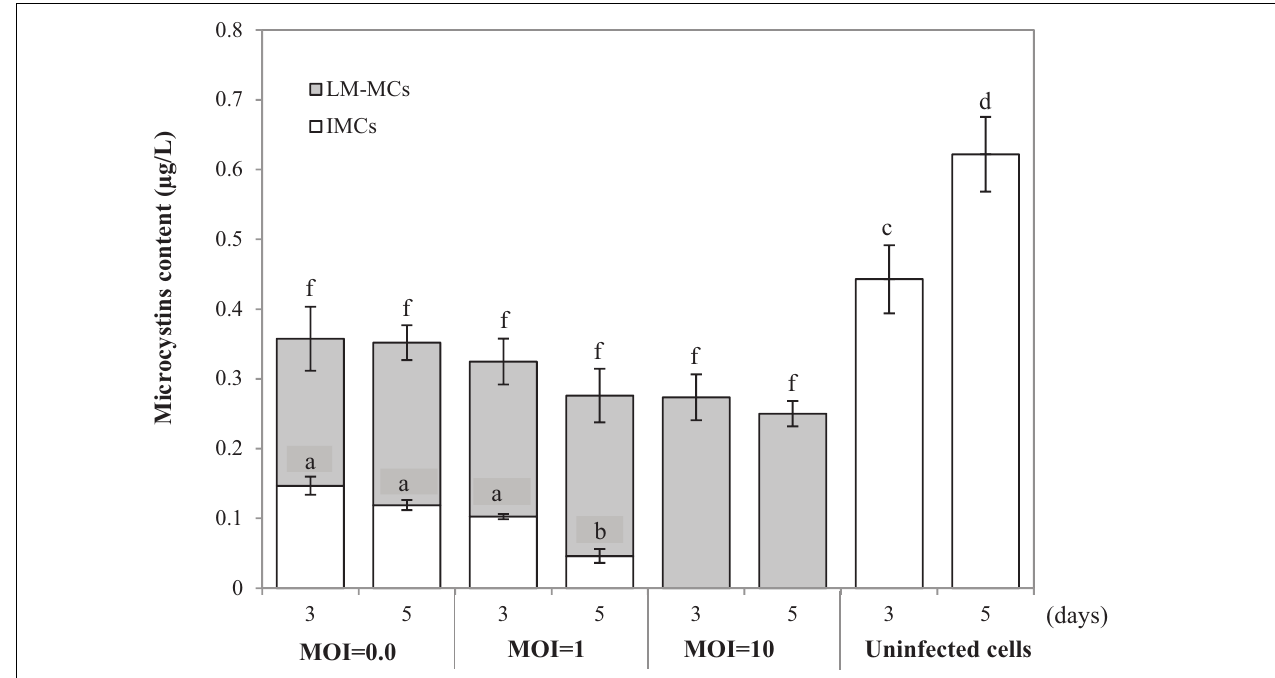
FIGURE 5 | Changes in accumulated microcystins (IMCs) and lysis-mediated microcystins (LM-MCs) on days 3 and 5 of the control and PhiMa05 infected culture of Microcystis SG03 at MOIs of 0.01, 1, and 100. Each data point is the mean from three independent experiments. Error bars show standard deviations. Different letters above bars show values that are significantly different ( p < 0.05). Each value is compared within each